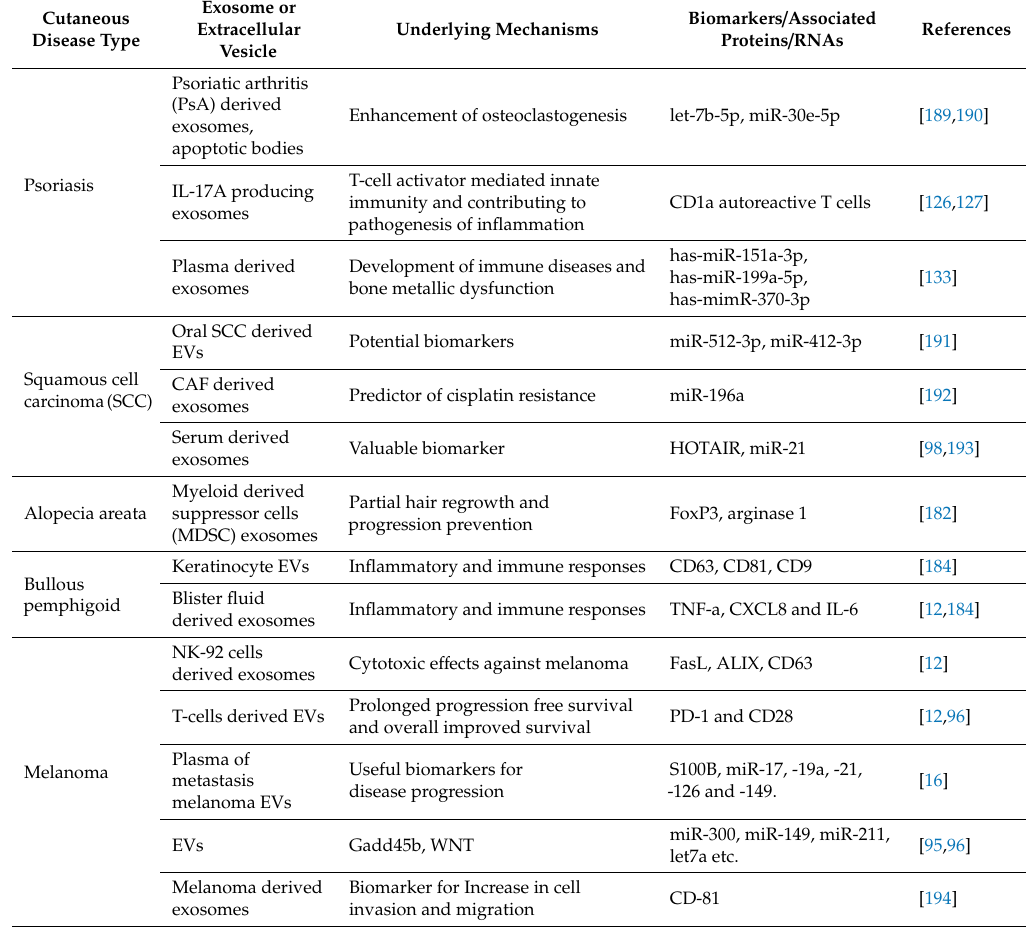
Table 1. Role of EVs in cutaneous